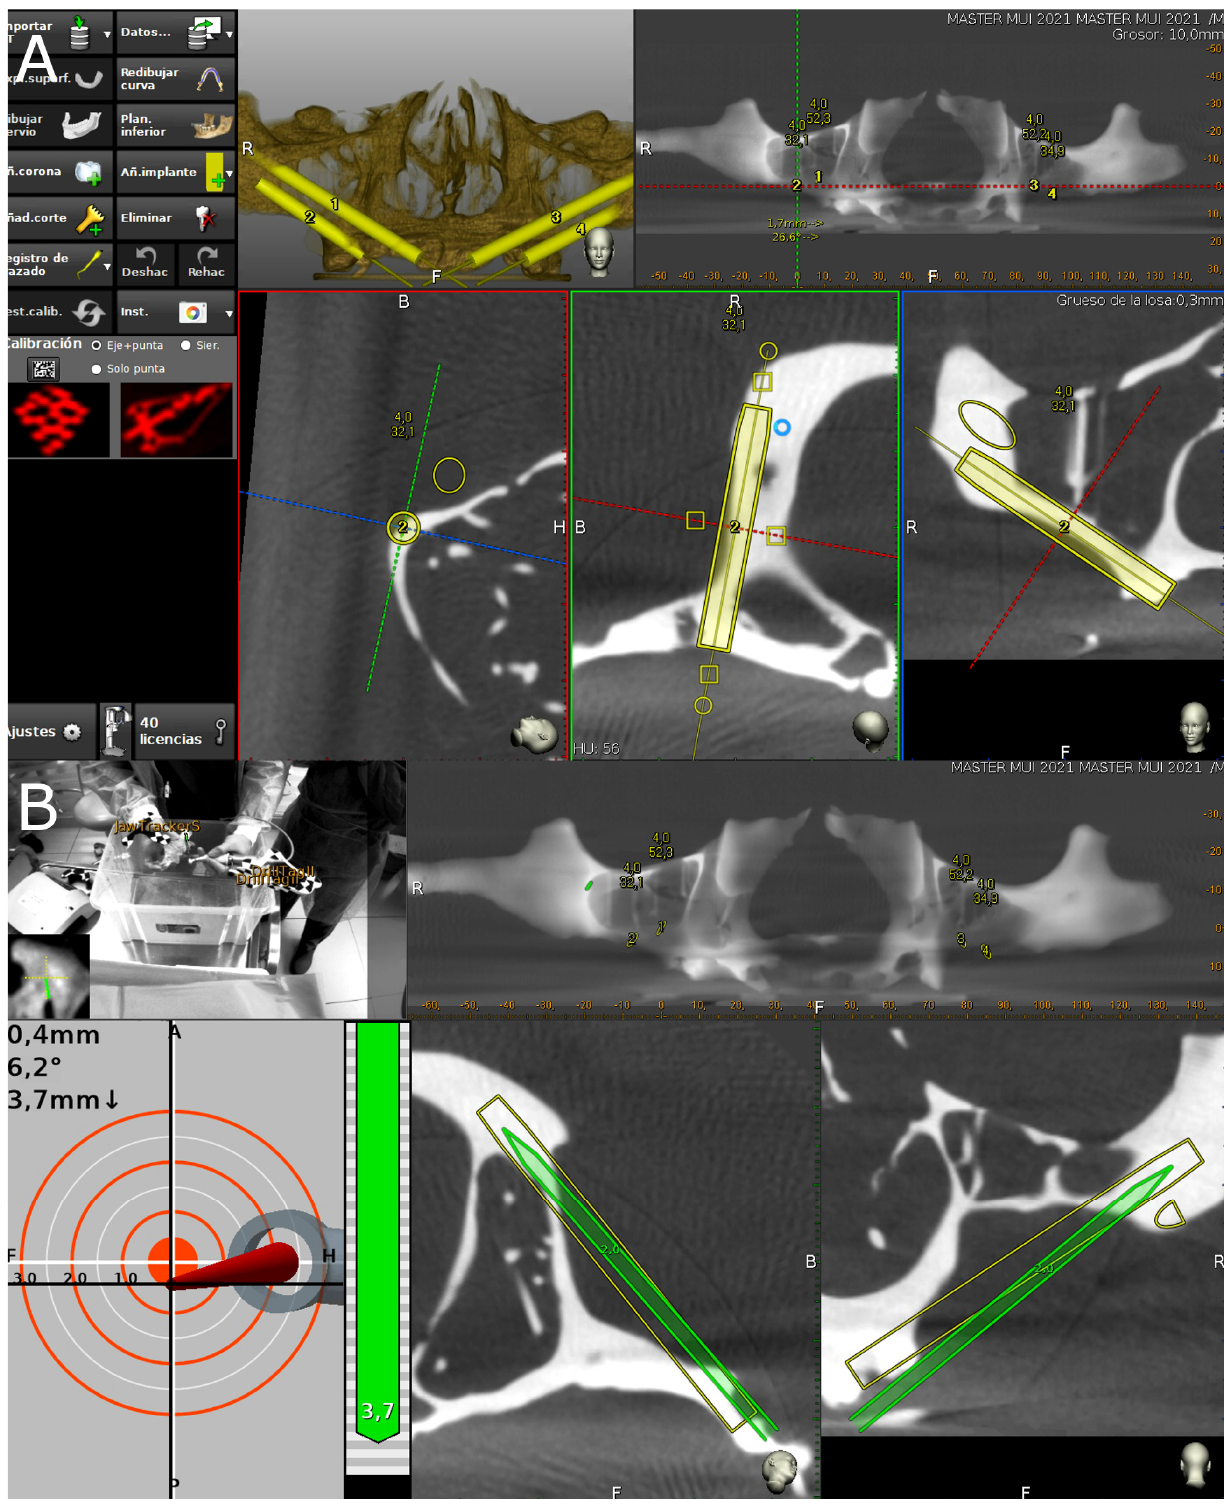
Figure 3. ( A ) Preoperative planning of placement of ZIs with the dynamic navigation appliance using treatment-planning software, and ( B ) tracking procedure during ZI placement.